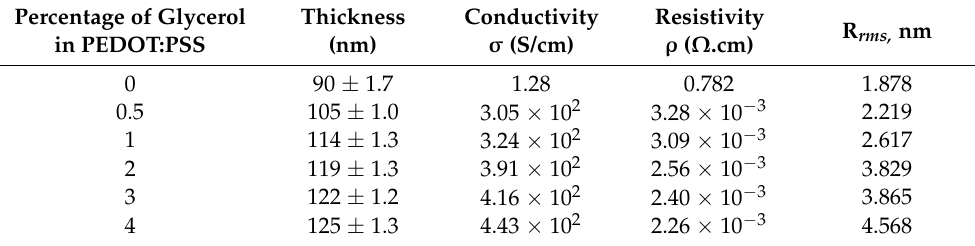
Table 1. The thickness ( t ), conductivity ( σ ), resistivity ( ρ ) and surface roughness (R rms ) of the films. The conductivity, σ of plasticized PEDOT:PSS thin films significantly increased with the addition of glycerol, suggesting that the presence of glycerol helped in rearranging the PEDOT:PSS morphology and improved interconnections between the PEDOT